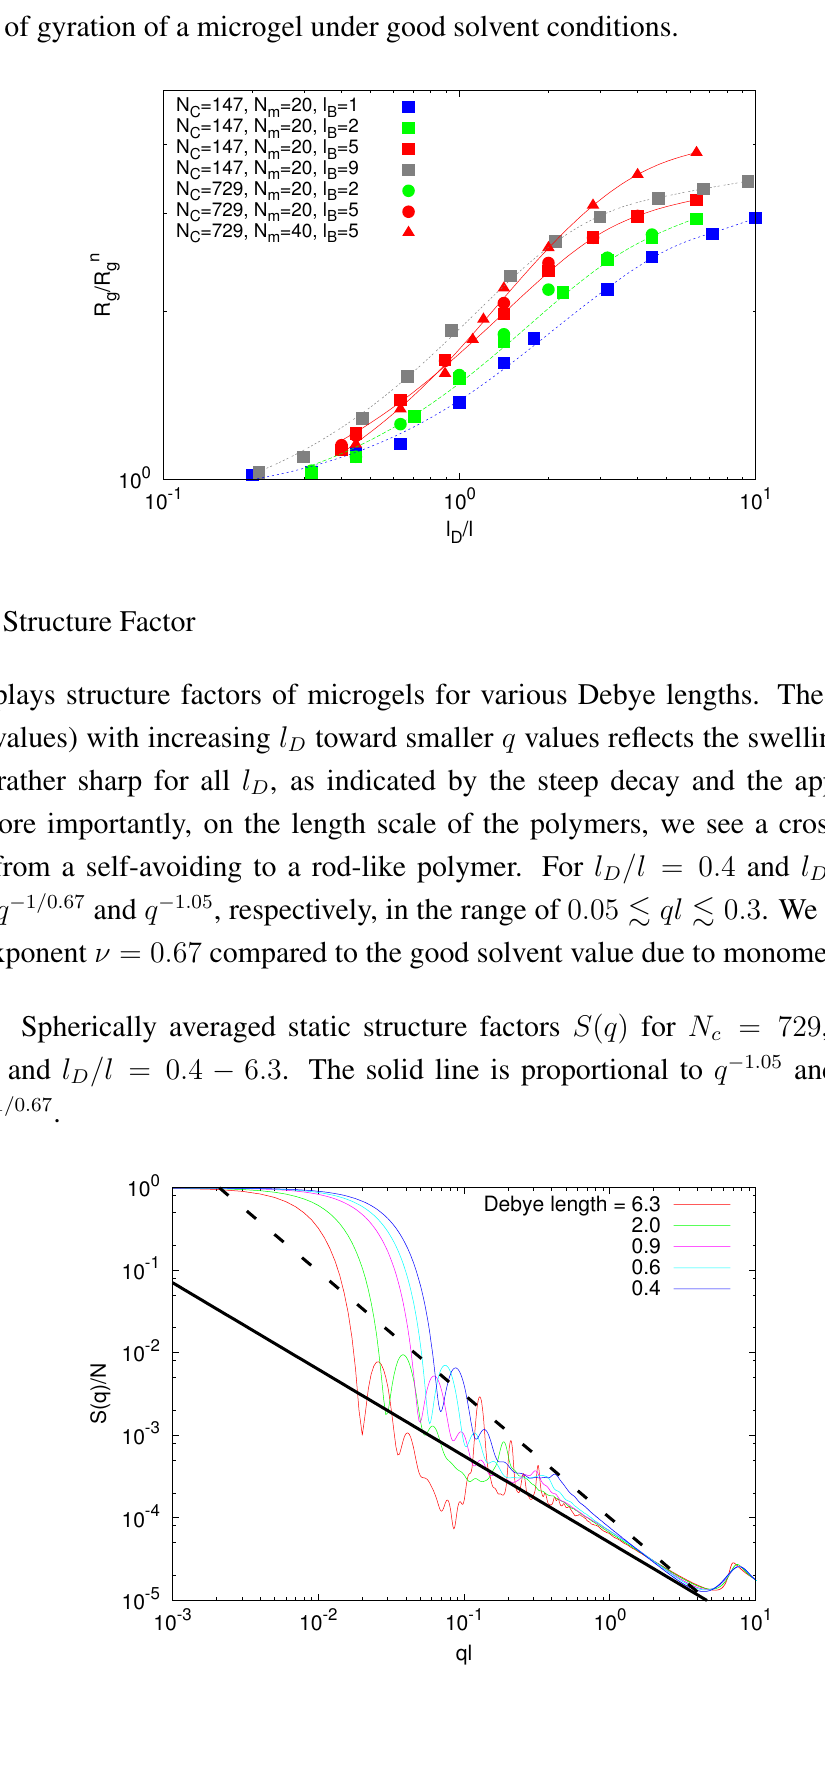
, of a microgel on the Debye length, g = 20 and 40 , and N = 147 and 729 . R n , N B m c